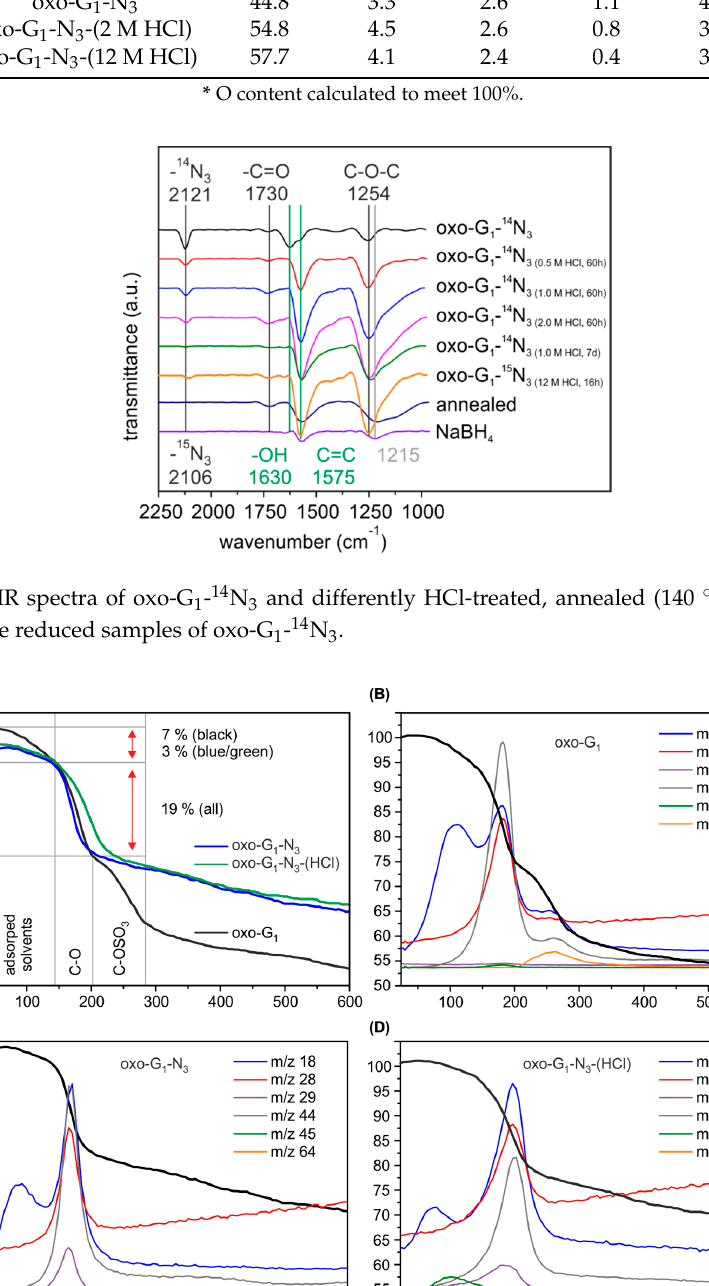
Table 1. Elemental analysis of oxo-G 1 - 14 N 3 and HCl treated derivatives.